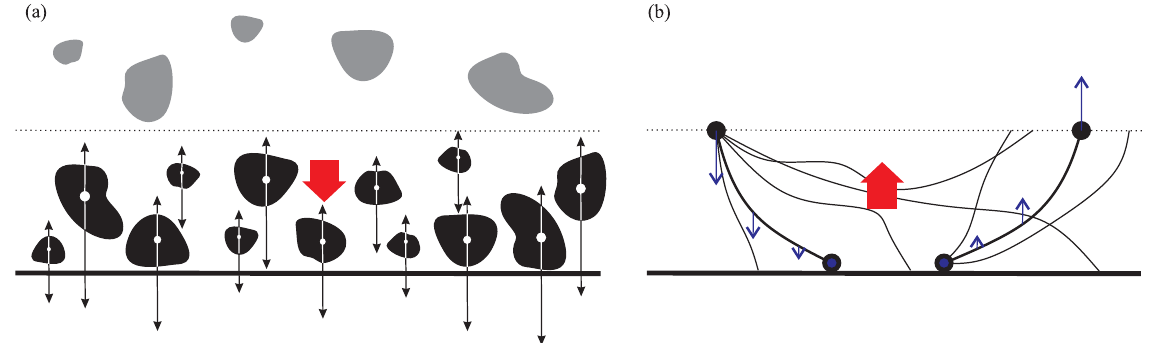
Figure 1. Schematic diagram of gravity and turbulence acting on the suspension within the near-boundary region. (a) Each particle is acted upon by a downward-directed gravitational force and upward-directed buoyancy force (black arrows). Particles in suspension above the near-boundary region, indicated in grey, are not considered herein. The red arrow indicates F g acting on the suspended particle load within the near-boundary region. (b) The vertical turbulent velocity w (cid:48) (blue arrows) is 0ms − 1 at the impermeable no-slip boundary at the base of the suspension and increases throughout the near-boundary region. Parcels of suspension moving upwards or downwards through the top of the near-boundary region are subject to a multitude of possible velocity evolutions (thin black lines), which can be represented by the pathways of “fictitious average parcels” (thick black lines; Irmay, 1960). The blue arrows indicate the vertical component of velocity; parcels with decreasing downward velocities and increasing upward velocities both experience upward acceleration. The red arrow indicates F turb derived from this average upward fluid acceleration.